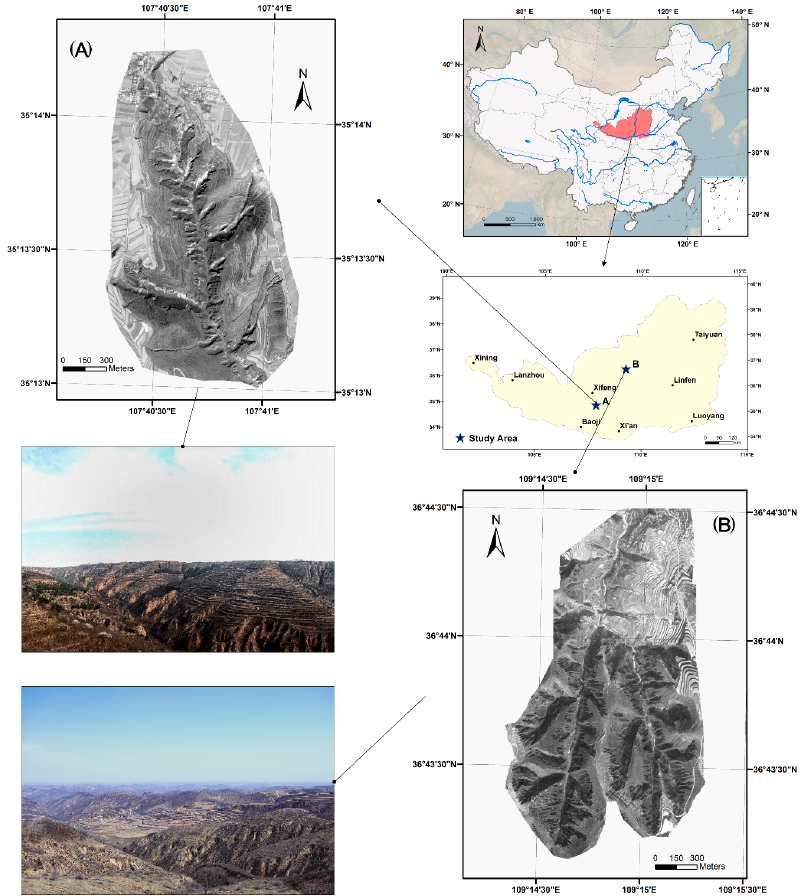
Figure 1. Location of study areas, the worldview-3 images and the photos captured during the filed investigation in (A) Ansai and (B)